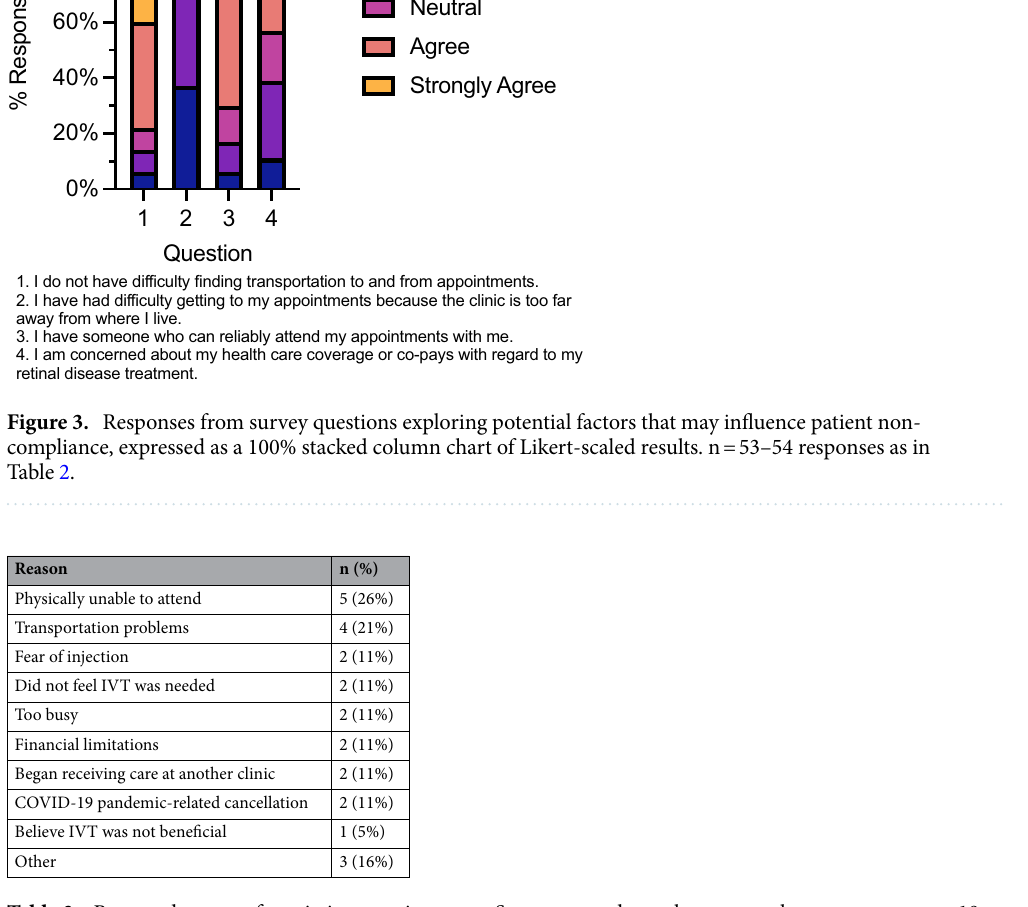
Table 3. Reported reasons for missing appointments. Some respondents chose more than one reason. n =